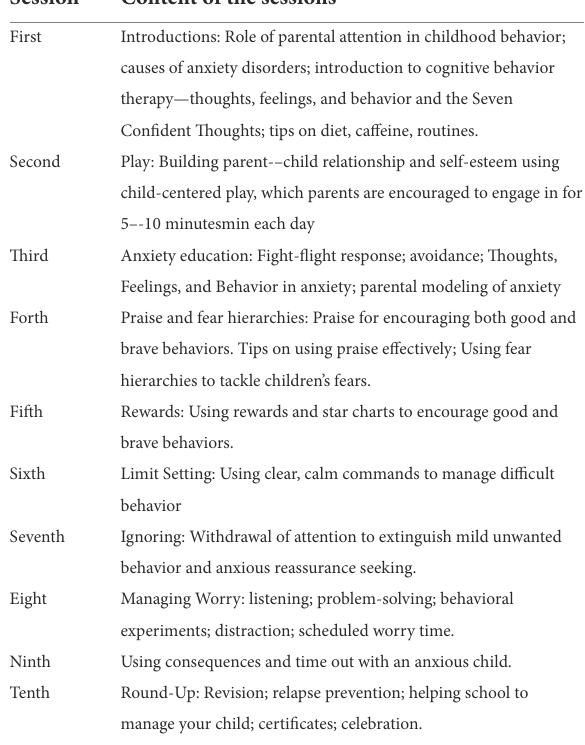
TABLE 2 Content of the FTTT program